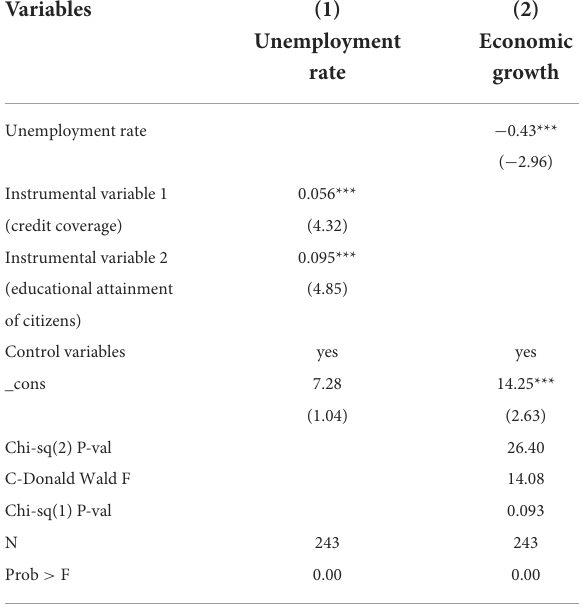
TABLE 3 The impact of unemployment on economic growth: An instrumental variables approach.